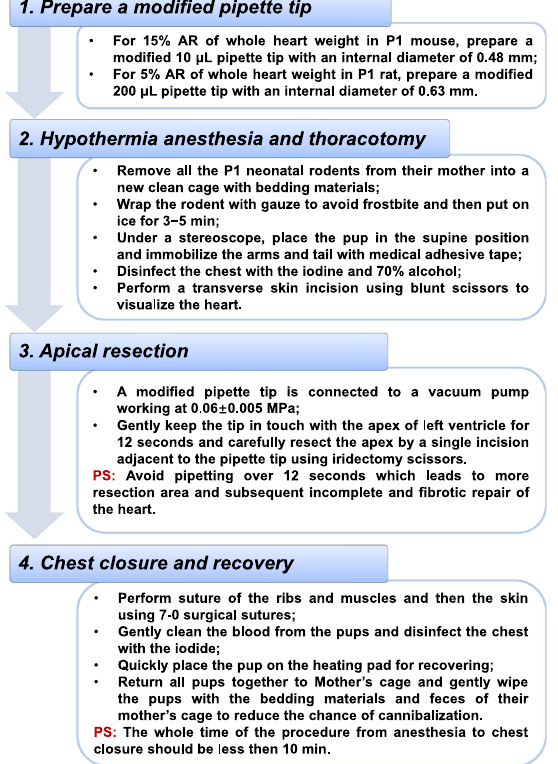
Fig. 1 A schematic fl ow chart illustrating the major operation process of modi fi ed apical resection model in 1-day-old neonatal rodents. A modi fi ed pipette tip cut to a given internal diameter is prepared for the modi fi ed apical resection model. After hypother- mia anesthesia and thoracotomy, the modi fi ed pipette tip, which is connected to a vacuum pump working at 0.06 ± 0.005 MPa, is gently kept in touch with the apex for 12 s. Apical resection is performed by a single incision adjacent to the pipette tip. Finally, chest closure is performed and rodents are returned together to mother ’ s